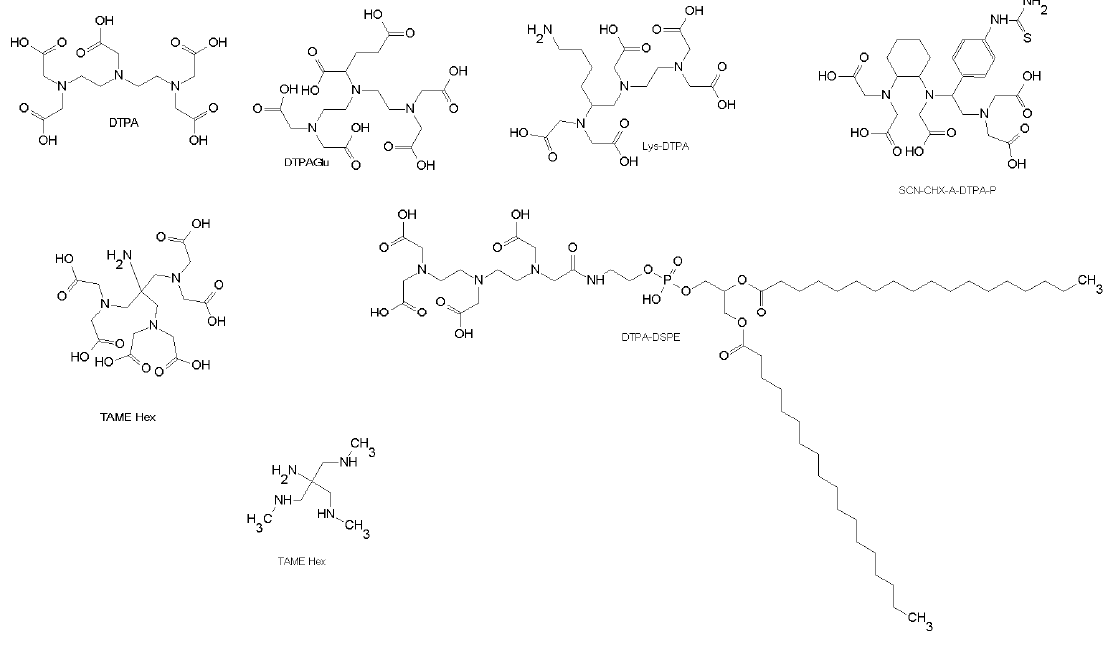
Figure 3. Chemical structures of DTPA chelators.